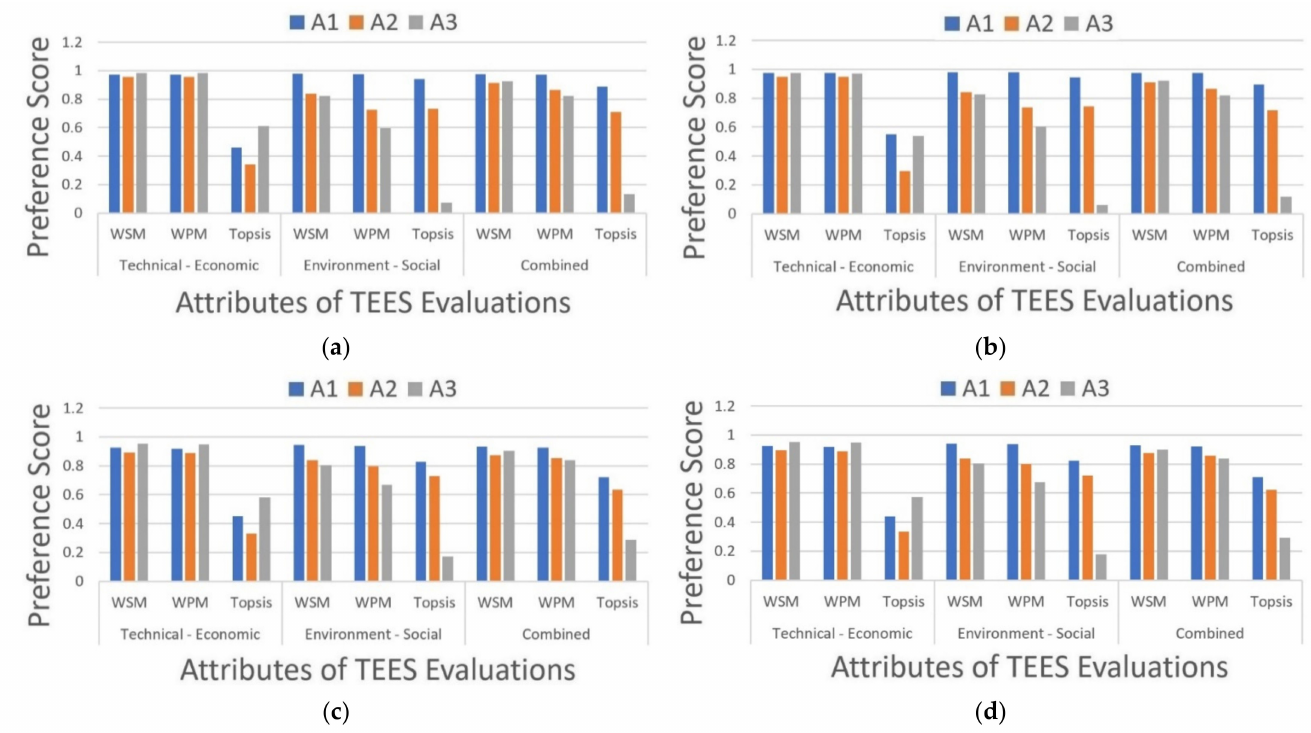
Figure 22. MCDM evaluations for Case 5 considering DG only: ( a ) C5/S2 (LG1); ( b ) C5/S3 (OLG1); ( c ) C5/S4 (LG2); ( d ) C5/S5